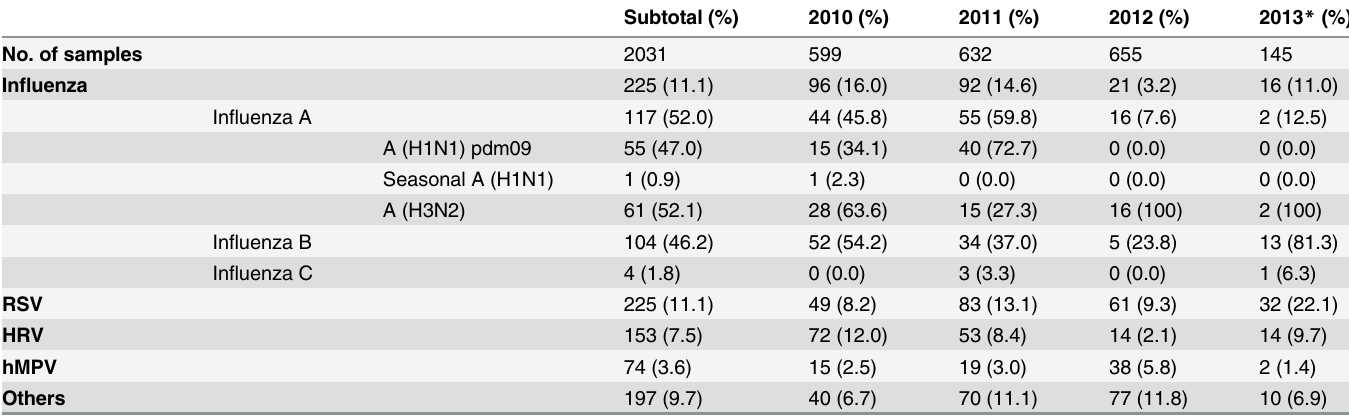
Table 2. Viral etiology for influenza-like illness (ILI) cases from 2010 to